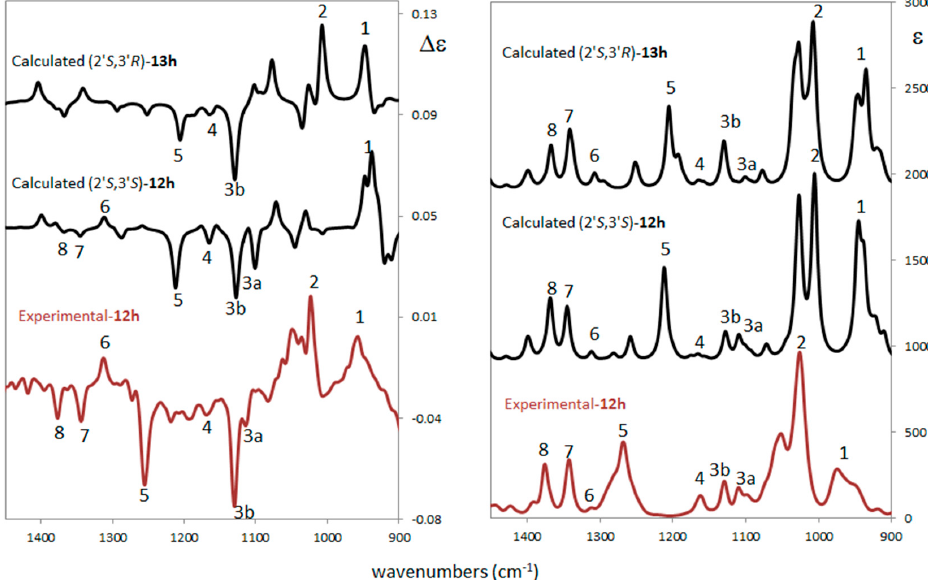
Figure 4. Comparison of experimental and computed vibrational circular dichroism (VCD) ( left ) and infrared (IR) ( right ) spectra for the different ACs for compound trans - 12h (experimental and calculated) and cis - 13h (calculated). Scaling factor = 0.98 (see Supplementary Materials for details).